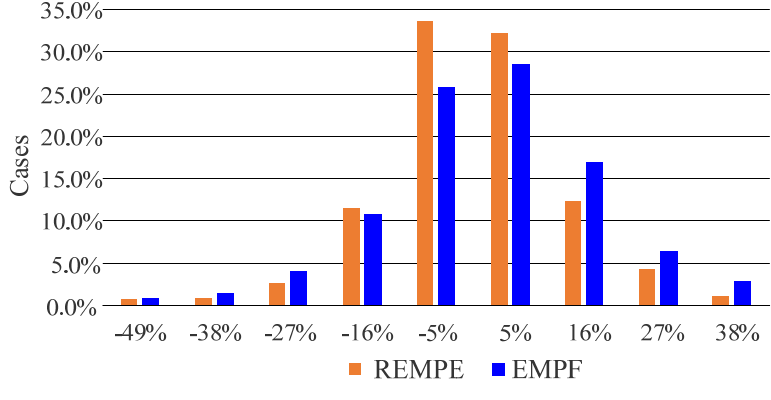
Figure 8. Histogram of the error values of the EMPF model and the REMPE model for the out-sample data set.